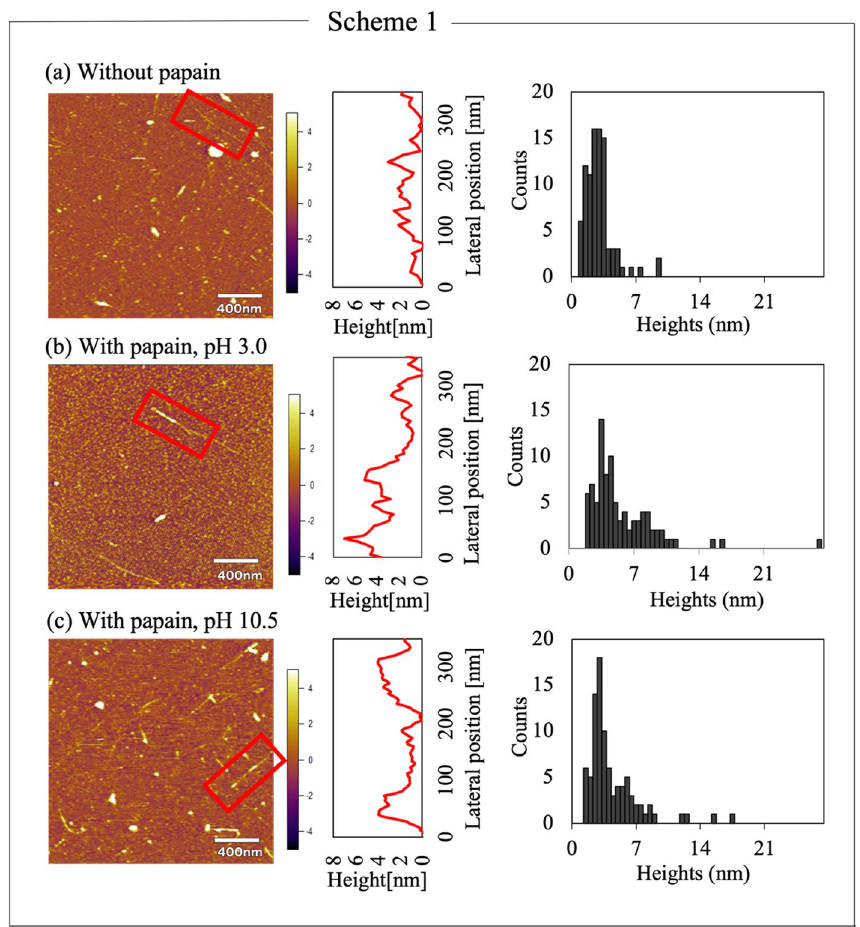
Figure 2. AFM images and height histograms of the DNA–SWNTs ( a ) before the injection of papain solution, ( b ) after the injection under pH 3.0, and ( c ) after the injection of papain under pH 10.5. ( a ) Was analyzed in an AFM-liquid condition after dropping the DNA–SWNT solution onto the AP-treated mica substrates. ( b ) and ( c ) Were analyzed similarly after injection of the papain solution. The histogram was illustrated using the height data corrected with those of gold